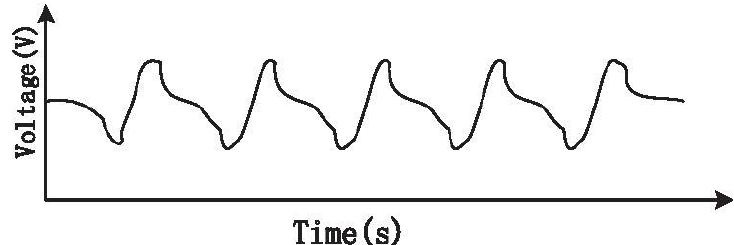
Figure 12. CO sensor signal after eliminating 2